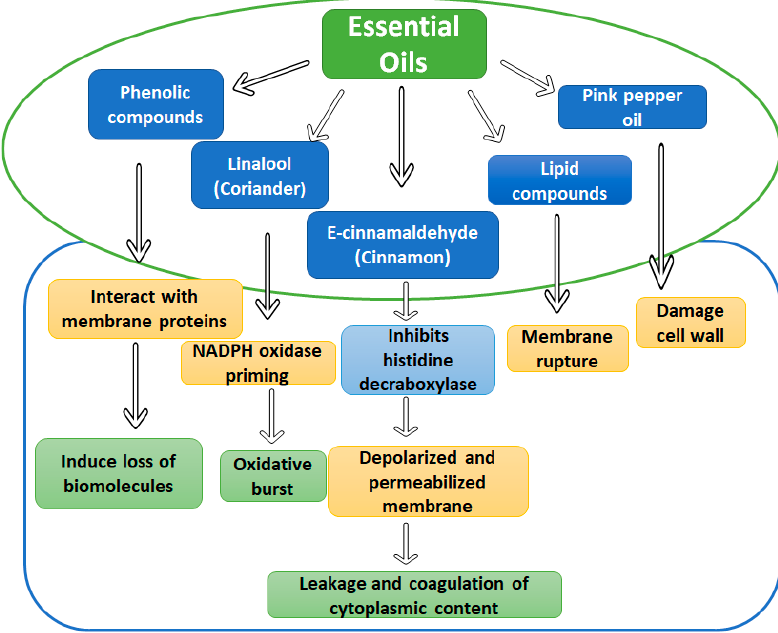
Figure 3. Mechanism of various essential oils as bio-preservatives.